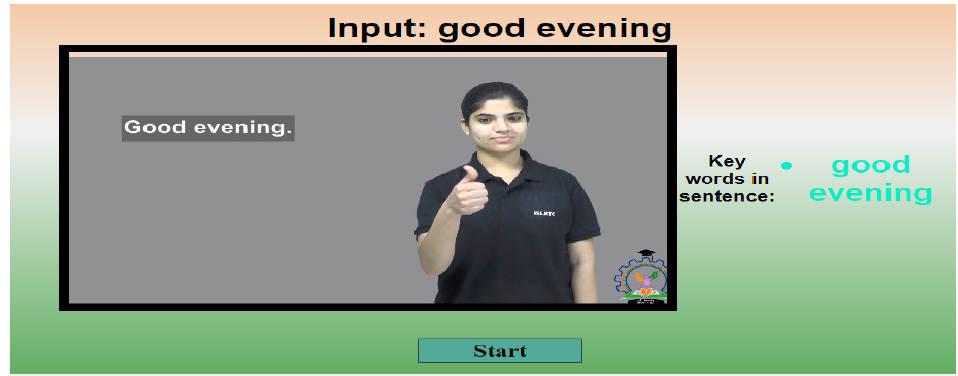
Figure 21. Case 10. Available video for ‘good evening’.